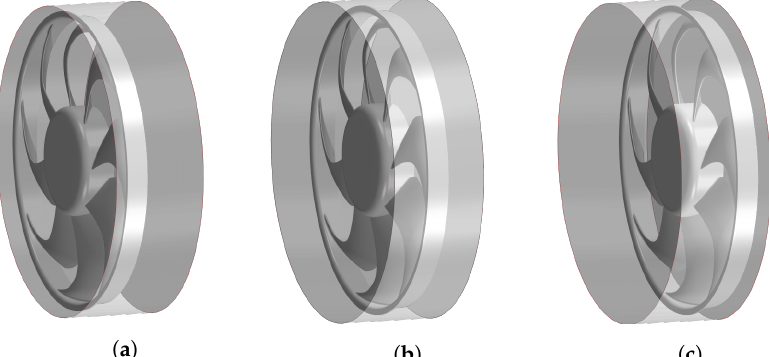
Figure 2. Placement of the multiple reference frame (MRF) zone in relation to the fan blades (case T2): ( a ) upstream interface close to the blades, ( b ) equal distance between blades and up-/downstream interface, ( c ) blades close to the downstream interface.